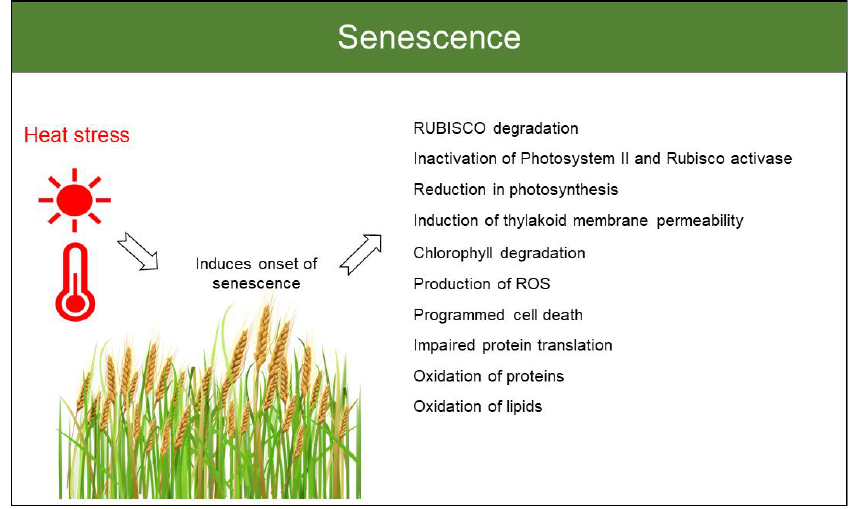
Figure 3. Adverse effects of induced senescence mediated by heat stress in plants.